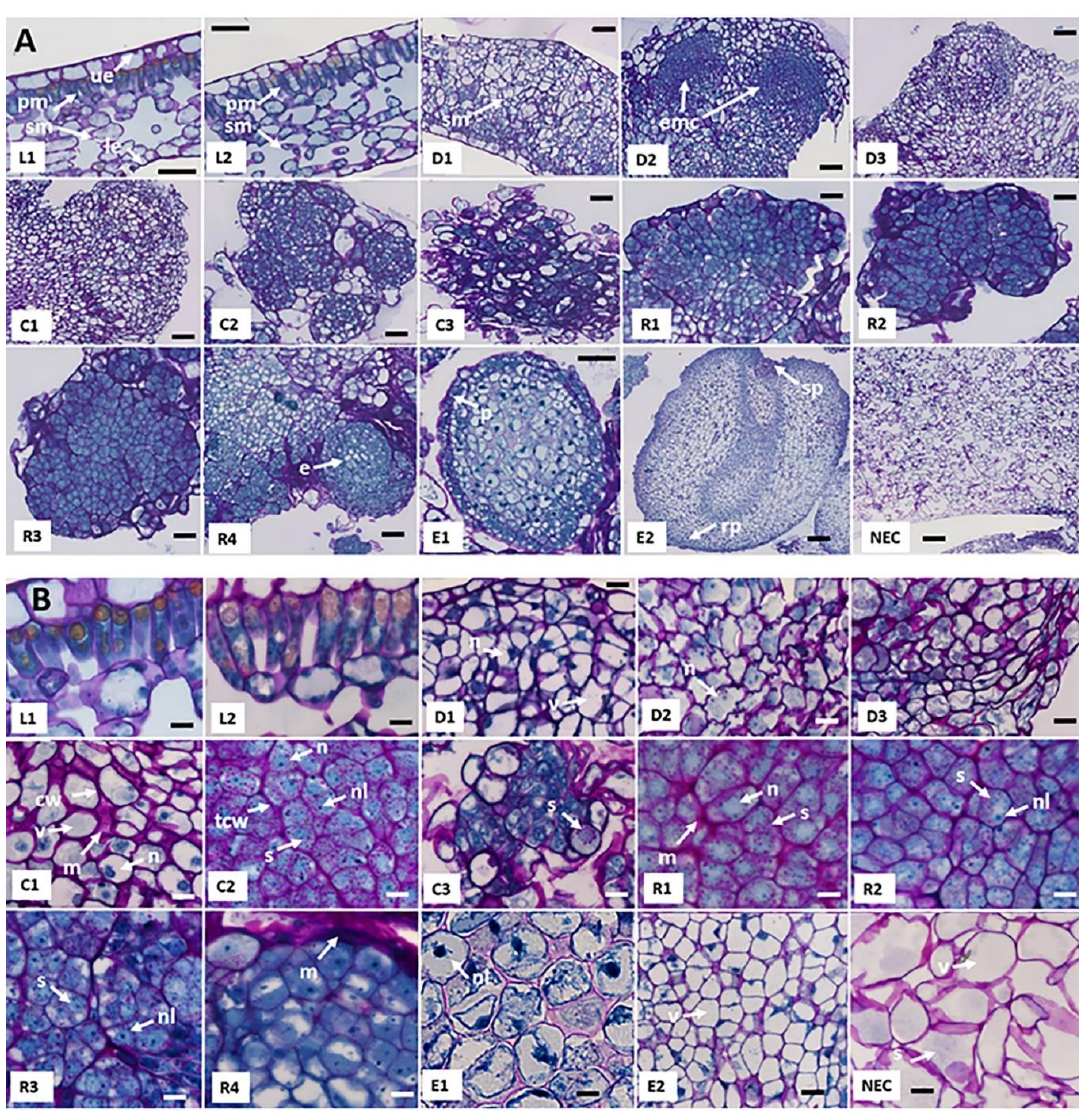
Figure 2. Characterization of 15 key sampled stages throughout the Arabica SE process at a histological ( A ) and cellular level ( B ). Sampled stages correspond to: leaves from greenhouse plants (L1), explants during dedifferentiation [0 h (L2), 1 week (D1), 2 weeks (D2), 5 weeks (D3)], compact primary callus obtained 3 months after induction (C1), embryogenic callus obtained 7 months after induction (C2), established cell clusters obtained after 4 months in liquid proliferation medium (C3), pro-embryogenic masses [1 week in redifferentiation medium after auxin withdrawal (R1), 24 h in redifferentiation medium after reducing cell density (R2), 72 h (R3), 10 days (R4)], globular embryos (E1) and torpedo-shaped embryos (E2). An additional stage, the non-embryogenic callus (NEC), was also sampled at the same time as the embryogenic callus (C2) and obtained in the same culture conditions. Sections were treated with 1% periodic acid and stained with Schi ff reagent (colors polysaccharides in purple) and Naphthol Blue Black (colors soluble proteins in blue). Images were taken in bright field. The scale bar is set to 50 µ m in ( A ) and 10 µ m in ( B ). White arrows indicate: cw: cell wall, e: embryoid